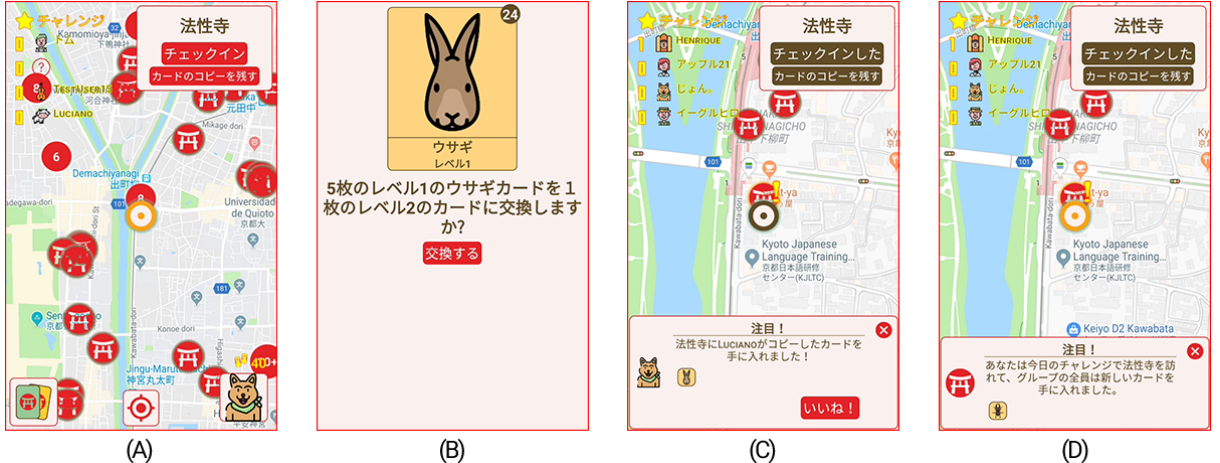
Figure 2. Examples of game screens. (A) Players used the map to search their neighborhood to find temples and shrines. (B) Players could visualize their cards and exchange 5 equal cards of a given level for 1 card of the next level. (C) Players could leave a copy of a card in a place they visited, and other players would see a mark in places where this was done. (D) Players were assigned to challenge groups and were notified when members of the group visited places, which added cards to all members of the